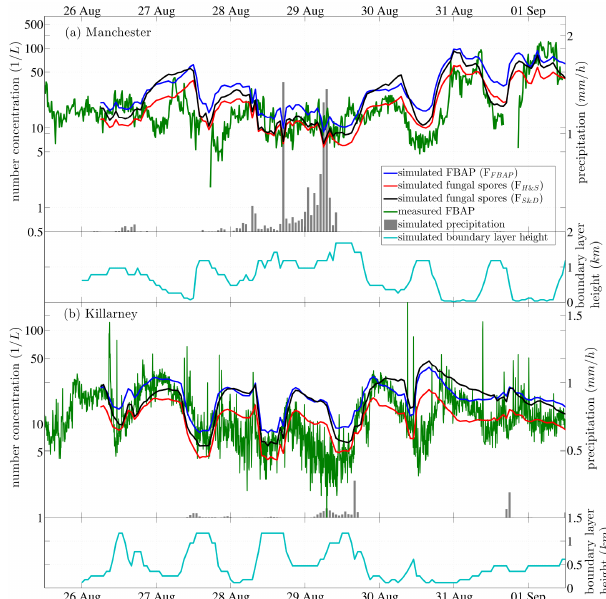
Figure 5. Time series of measured FBAP and simulated fungal spore/FBAP number concentrations in 1L − 1 together with simu- lated precipitation in mmh − 1 (right axis) and simulated bound- ary layer height in kilometers (right axis) during the case study from 26 August 2010 to 1 September 2010 at (a) Karlsruhe, Ger- many; (b) Hyytiälä, Finland. Simulations were performed with three different emission parameterizations: F H&S from Heald and Spracklen (2009), F S&D from Sesartic and Dallafior (2011), and F FBAP from this study.